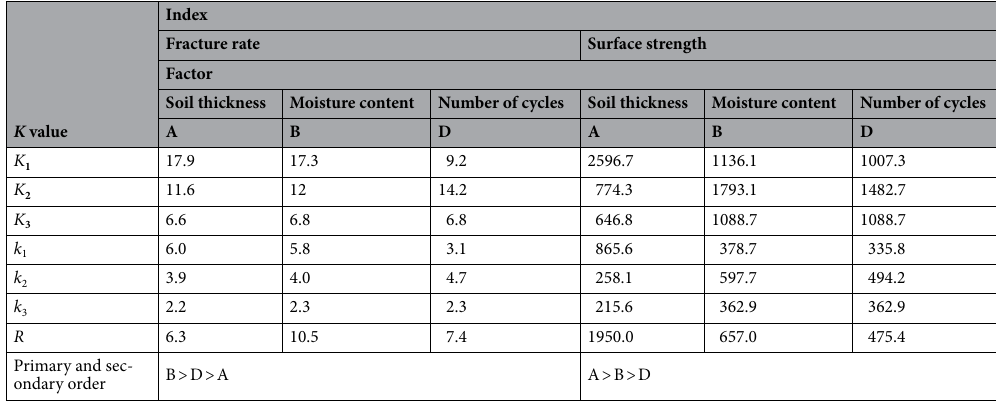
Table 8. Range analysis of freeze–thaw orthogonal test